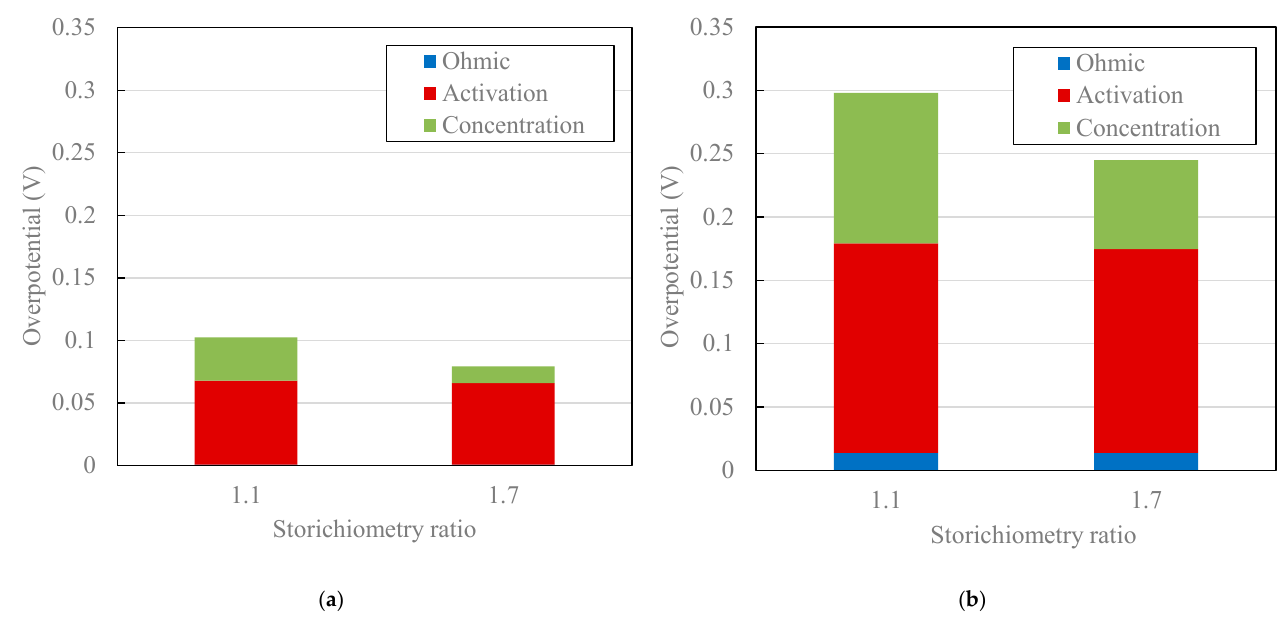
Figure 9. Comparison of the overpotentials for each stoichiometry ratio; ( a ) 0.6 A, ( b ) 10.0 A.